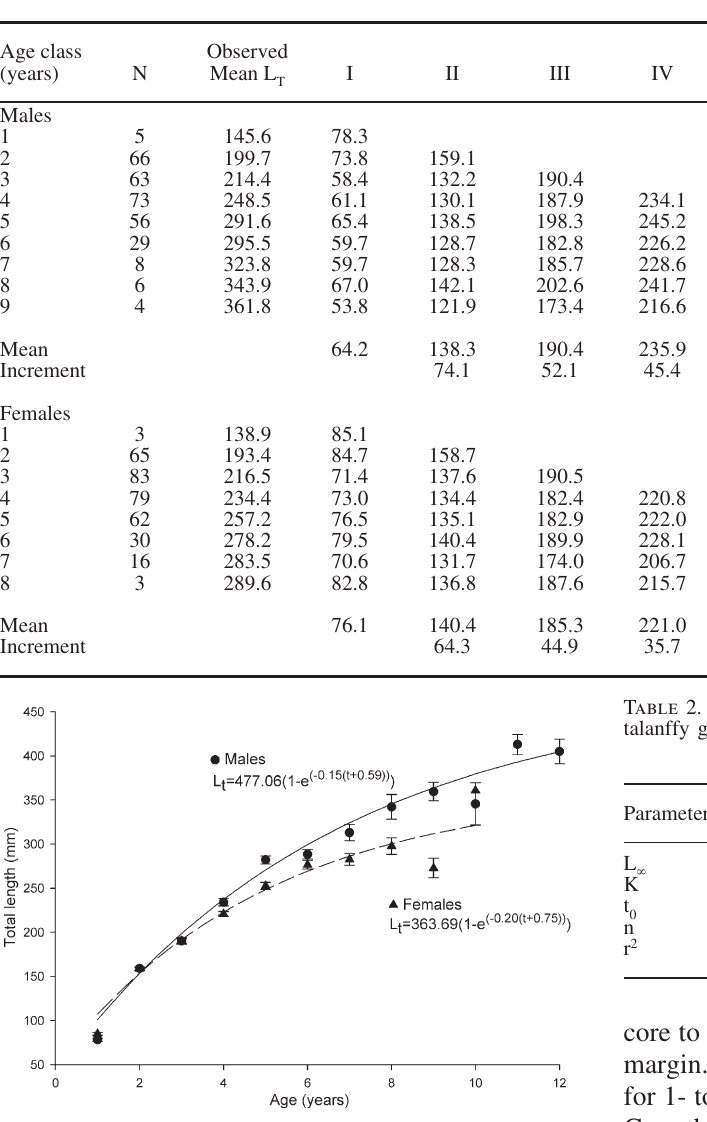
Table 1. – Mean observed and back-calculated lengths-at-ages for male and female H. didactylus sampled in the Bay of Cádiz between March 1999 and March 2000.